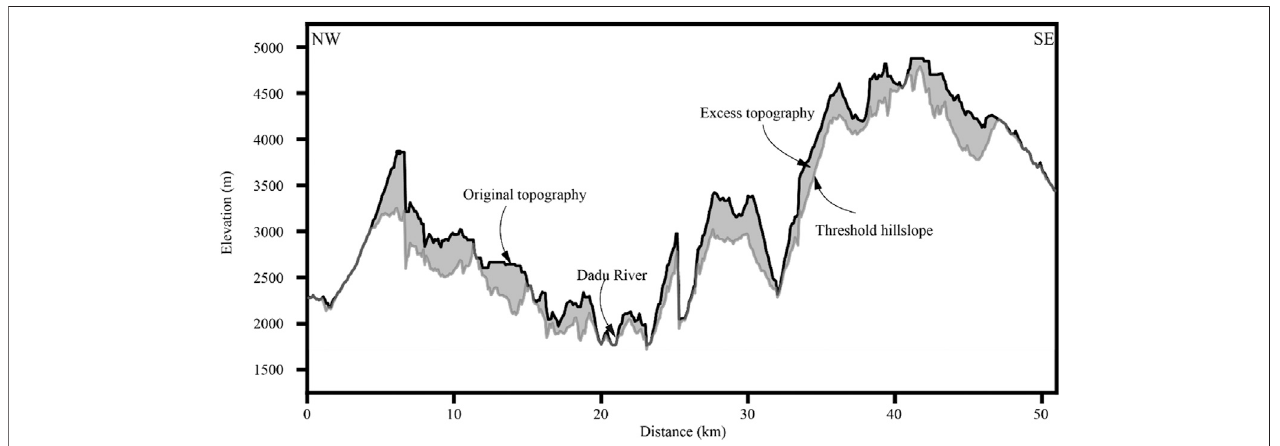
FIGURE 2 | Schematic diagram of excess topography. The black line represents the DEM elevation pro fi le, the gray line represents the threshold hillslope surface under 30 ° , and the gray shaded part represents excess topography.